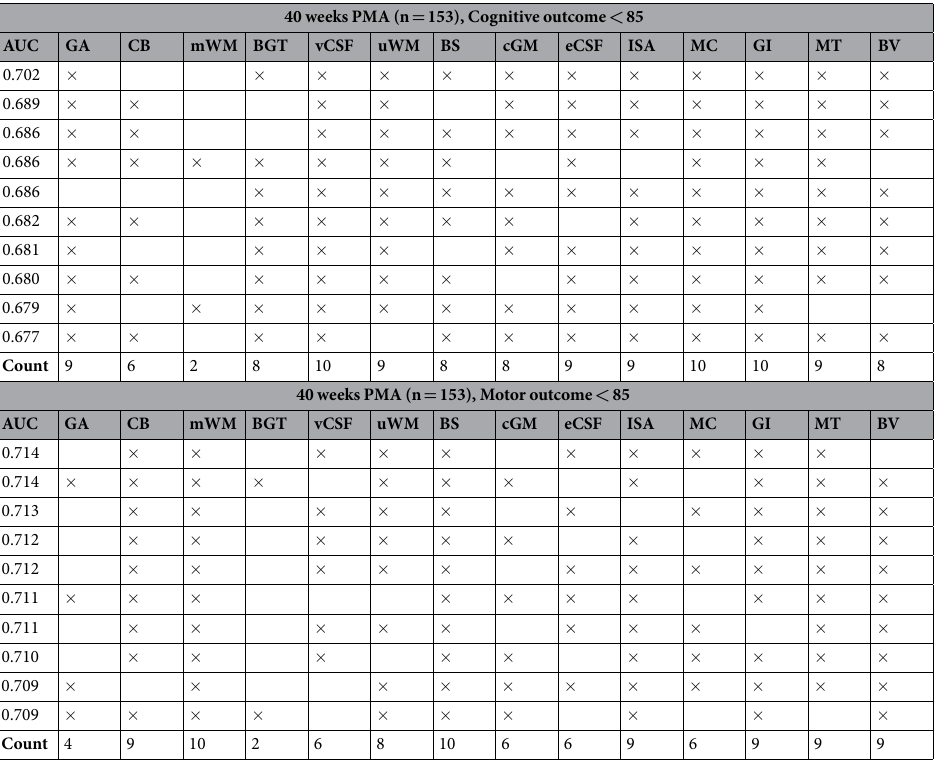
Table 3. AUCs for the 10 best performing combinations of descriptors for cognitive (top) and motor (bottom) outcome based on the images acquired at 40 weeks PMA. GA: gestational age, CB: cerebellum volume, mWM: myelinated white matter volume, BGT: basal ganglia and thalami volume, vCSF: ventricular cerebrospinal fluid volume, uWM: unmyelinated white matter volume, BS: brain stem volume, cGM: cortical grey matter volume, eCSF: extracerebral cerebrospinal fluid volume, ISA: inner cortical surface area, MC: global mean curvature, GI: gyrification index, MT: median cortical thickness, BV: brain volume. The bottom row shows in how many of the combinations each descriptor is